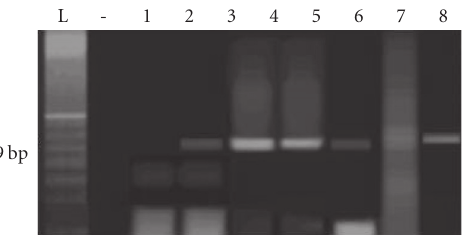
Figure 4. RT-PCR amplification of the enterotoxin A gene tran- scripts on the 6 S aureus isolates that tested positive for the corre- sponding gene by PCR. Lane L: 100-bp ladder; lane (-): negative control; lanes 1–7: RT-PCR amplicons of S aureus isolates from psoriatic patients; lane 8: 550-bp positive control.